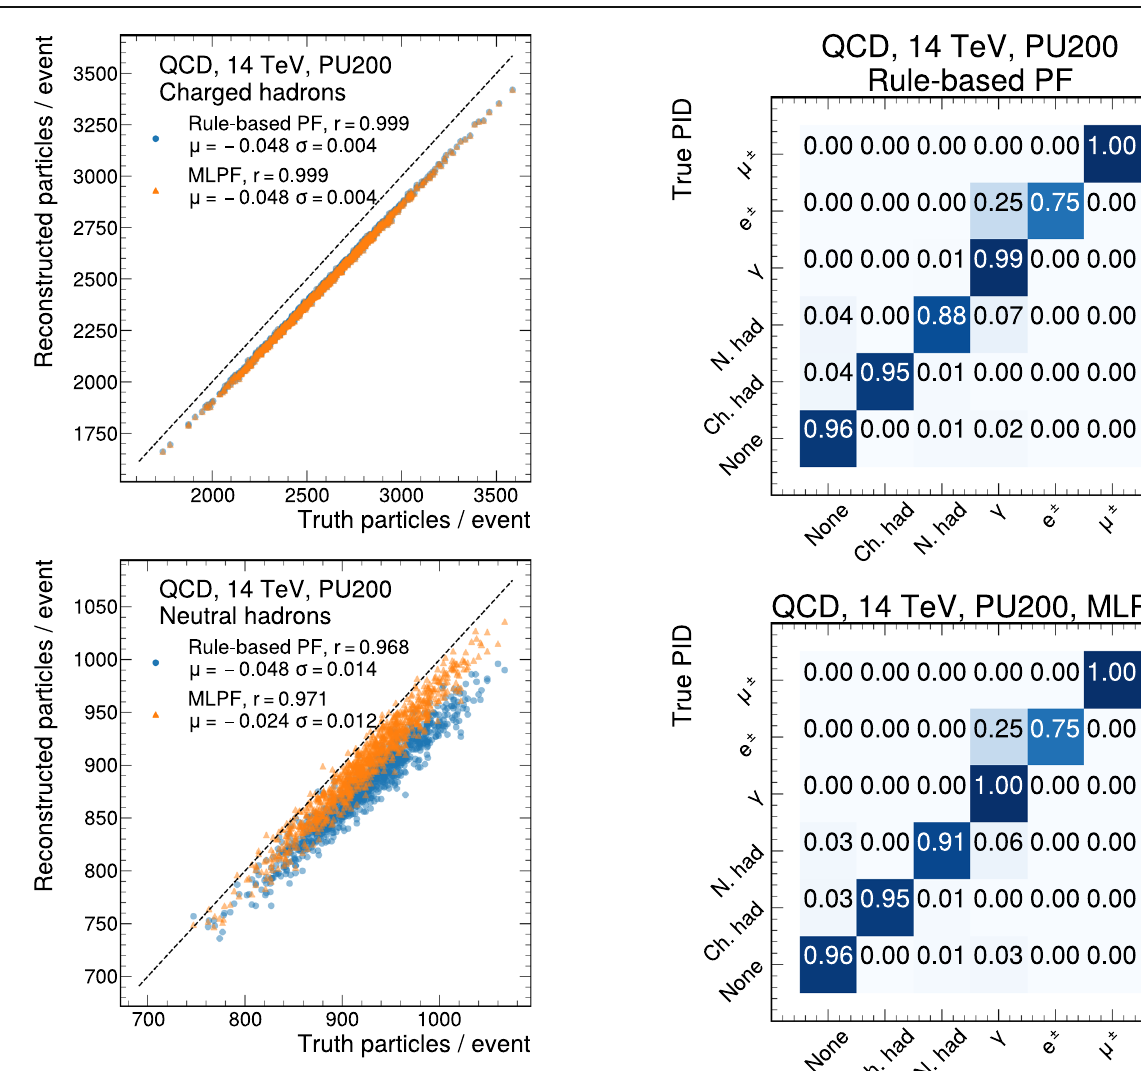
Fig. 5 True and predicted particle multiplicity for MLPF and delphes PF for charged (upper) and neutral hadrons (lower) in simu- lated QCD multijet events with PU. Both models show a high degree of correlation( r )betweenthegeneratedandpredictedparticlemultiplicity, with the MLPF model reconstructing the neutral particle multiplicities with improved resolution ( σ ) and a lower bias ( μ )